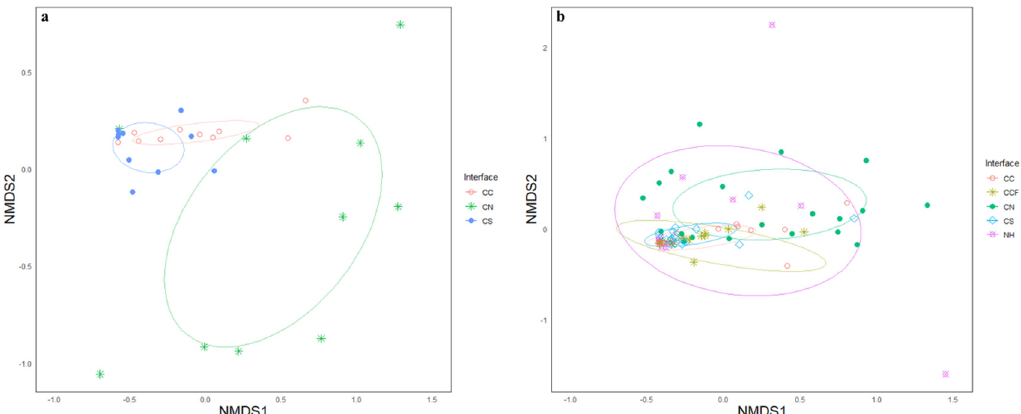
Figure 6. A Non-metric multidimensional scaling (NMDS) of Bray–Curtis similarity data of native bee communities in 2017 ( a ) and 2018 ( b ) across crop and semi-natural interfaces in a large-scale cotton agroecosystem. Each point is representative of a site placed according to their similarities with other sites, and ellipses representing the variance of the number of species within those sites. Widths of ellipses indicating the bee community similarity within sites at a given interface are greater than the similarities between the sites at different interfaces.